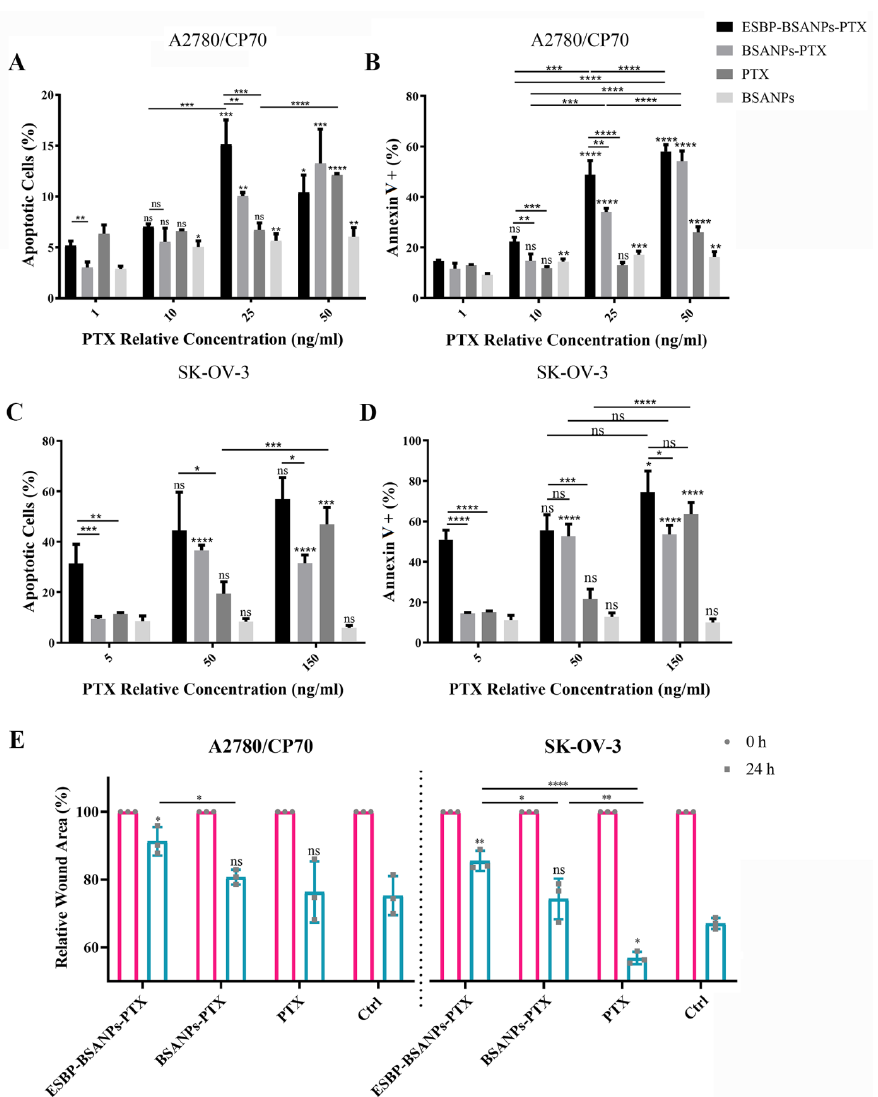
Figure 3. The apoptotic (PI+/Annexin V+) and Annexin V+ (PI+/Annexin V+ and PI-/Annexin V+) cells of ( A , B ) SK-OV-3 and ( C , D ) A2780/CP70 cell lines after 72 h of drug treatment with serial dilutions (mean ± SD, n = 3). The apoptosis and Annexin V+ percentages of each concentration were compared with that of the lowest relative concentration in the same drug treatment group